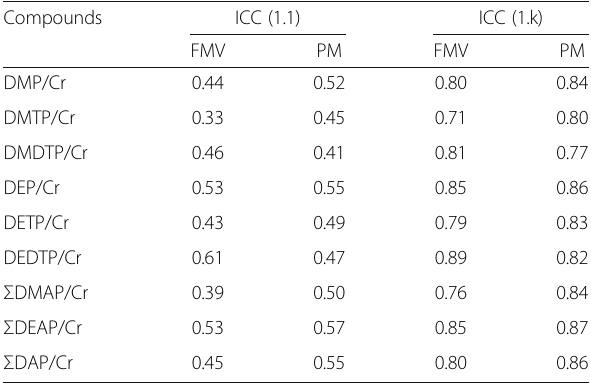
Table 3 Cr-adjusted ICCs of urinary OP metabolites affected by time of day of urine sampling